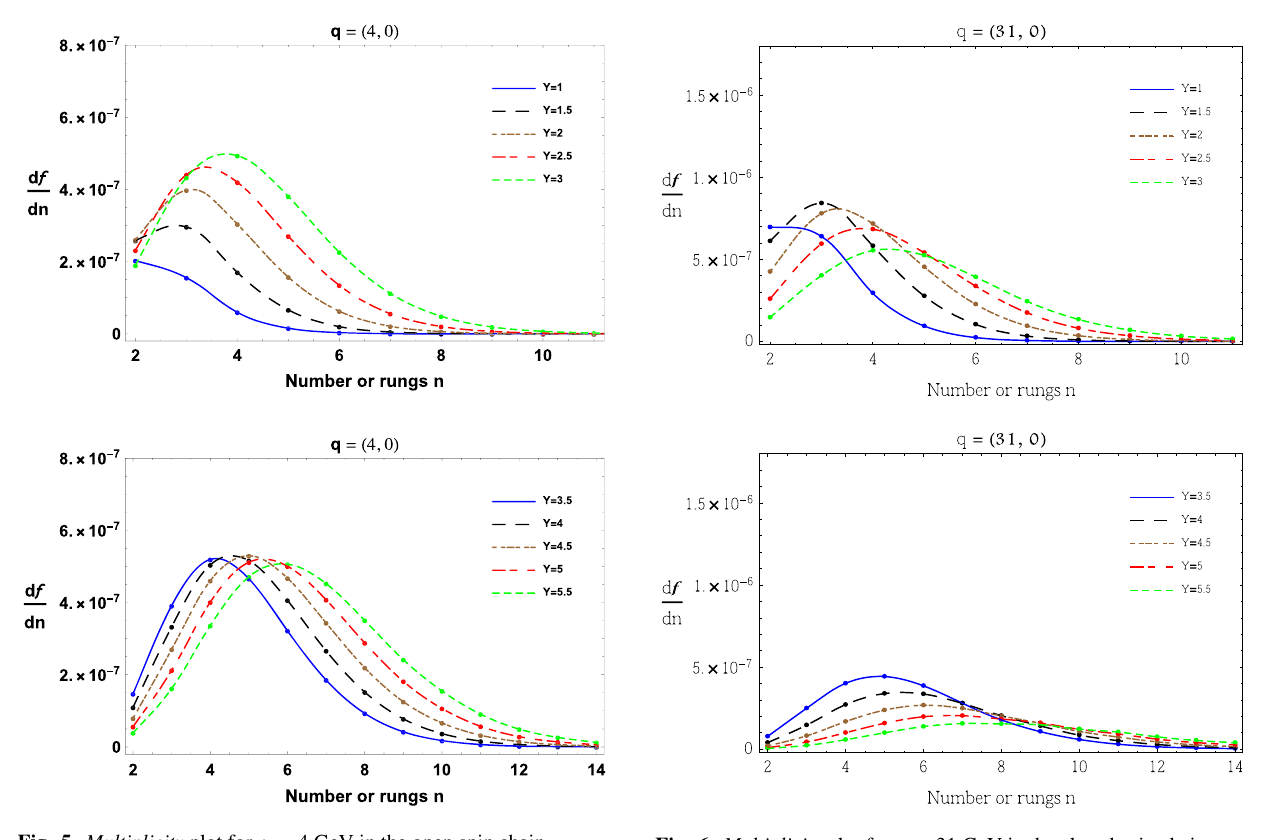
Fig. 5 Multiplicity plot for q = 4 GeV in the open spin chain Fig. 6 Multiplicity plot for q = 31 GeV in the closed spin